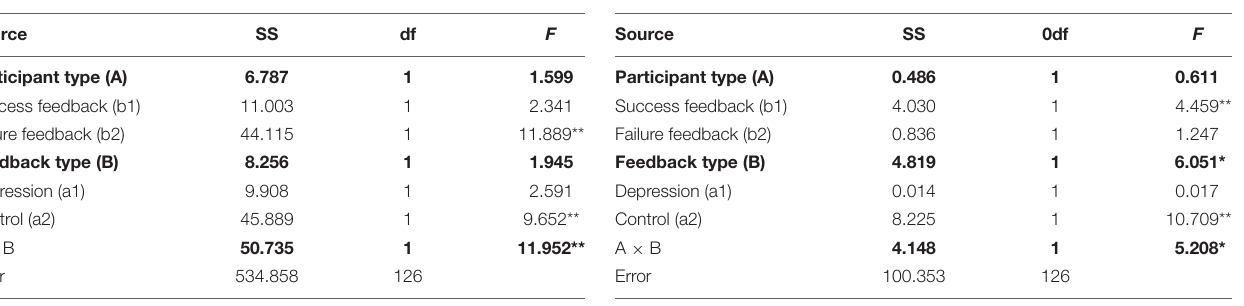
TABLE 5 | ANOVA of the SPM accuracy